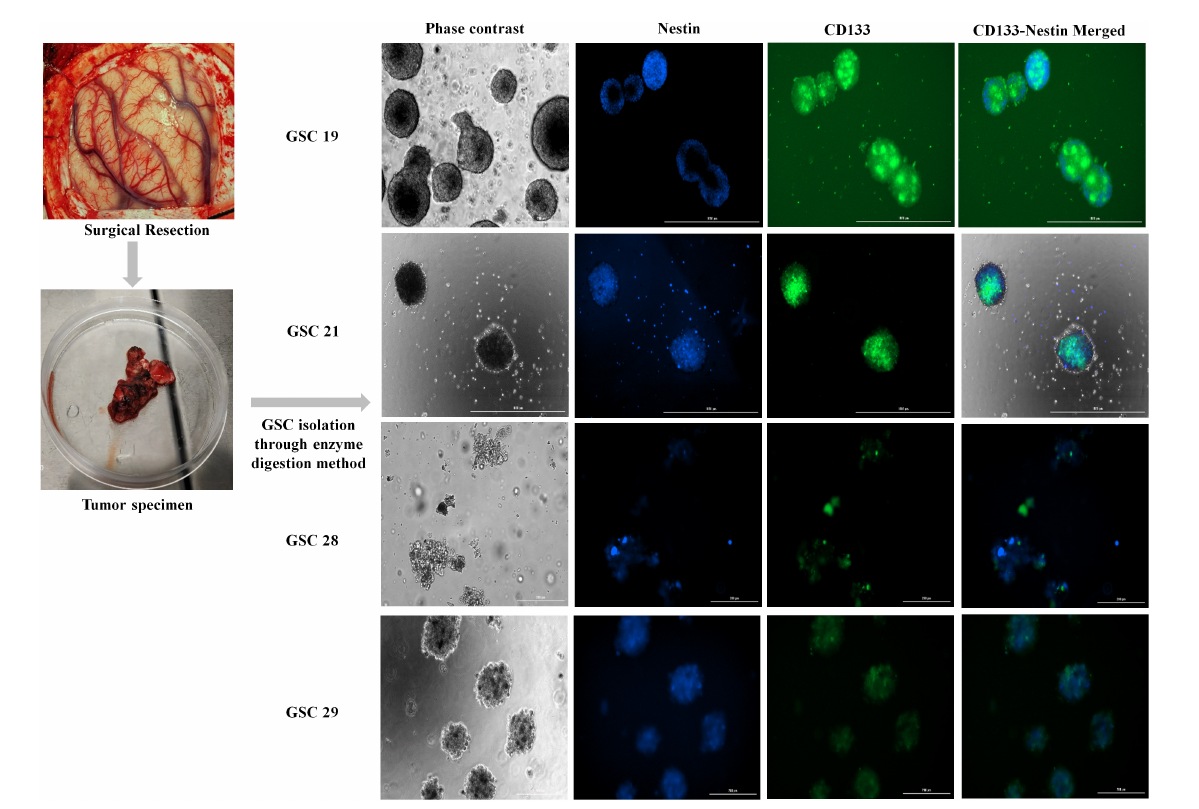
FIGURE1 Fluorescent images of ex vivo neurosphere cultures of glioma stem cells isolated from tumor specimens; GSC19, GSC21, GSC28, and GSC29 co-stained for stem cell markers Nestin and